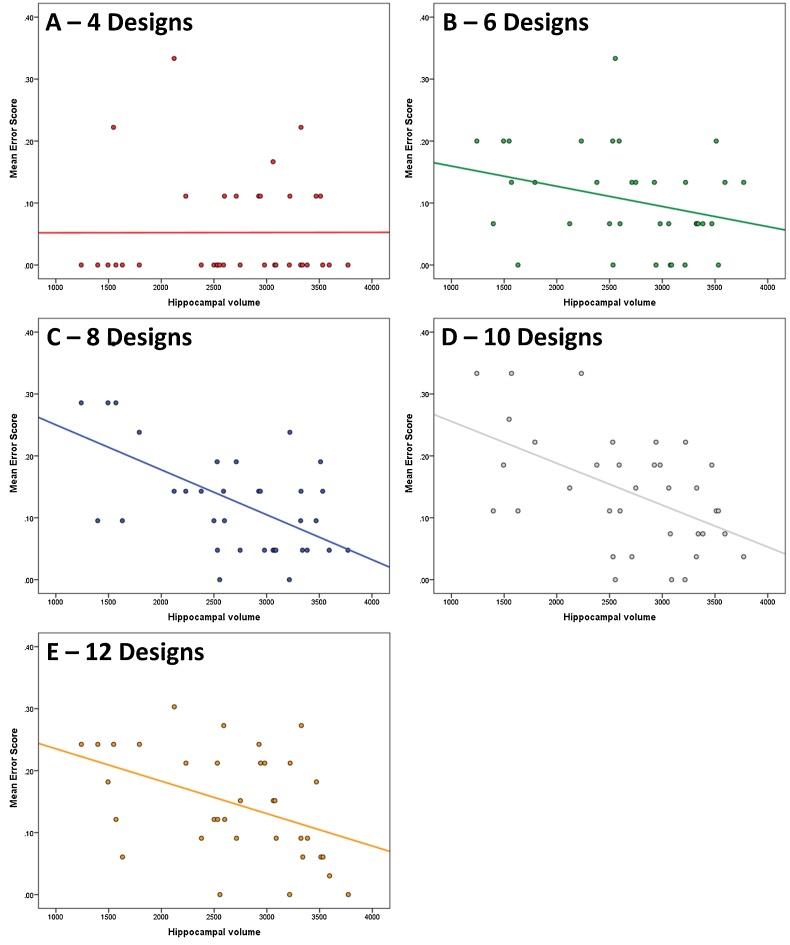
Mean error scores plotted against mean hippocampal volume (mm3), for the 4-designs (A), 6-designs (B), 8-designs (C), 10-designs (D) and 12-designs (E) conditions. Lines represent linear regression.